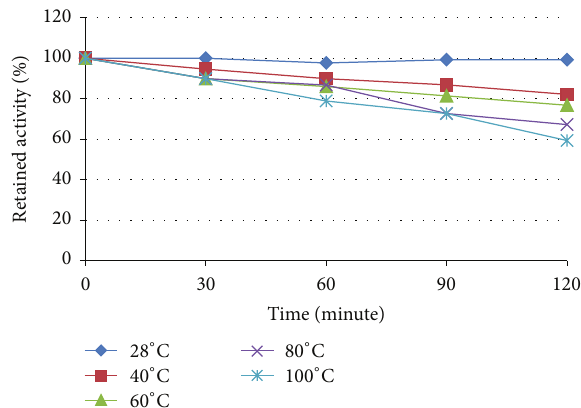
Figure 4: Thermal stability of the antifungal substance against F. oxysporum .